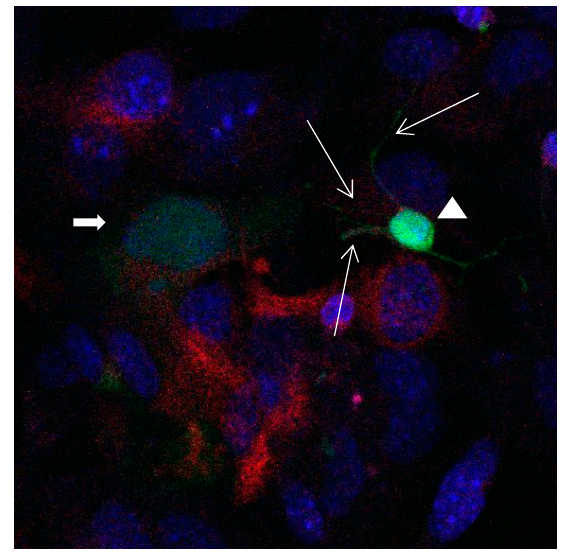
Figure 15. Cultures in a serum-containing medium, 1 day after the passage: Immunofluorescence with anti-GFAP (glial fibrillary acidic protein) (red, secondary antibody: donkey anti-goat IgG Alexa Fluor 594), and with anti-Calbindin D28k (polyclonal antibody from the company SWANT) (green, secondary antibody: donkey anti-rabbit IgG Alexa Fluor 488); Nuclear staining with DAPI (4 ′ ,6-diamidino-2-phenylindole dihydrochloride) (blue). Confocal microscopy. Zoom = 4. Left: a Calbindin D28k positive and GFAP positive astrocyte (short arrows). Besides: a Calbindin D28k positive and Calbindin D28k expressing neuron (triangle) with extensions (long arrows).